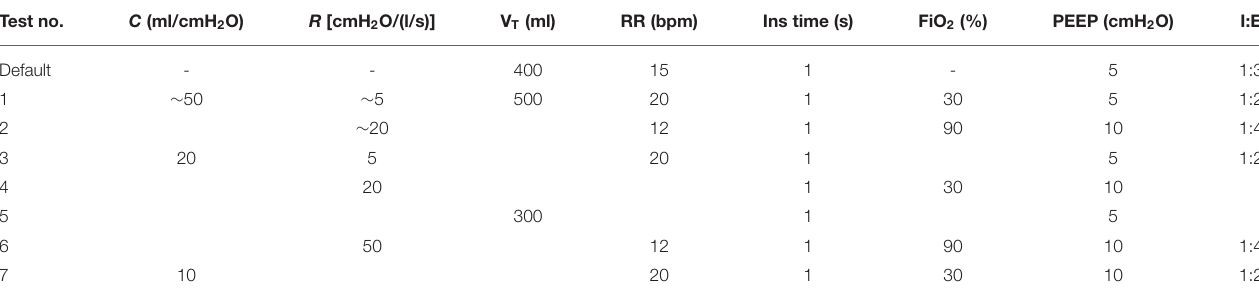
TABLE 2 | Ventilator test conditions from ISO 80601-2-12:2020. I:E ratios were calculated from RR and inspiration time. Test